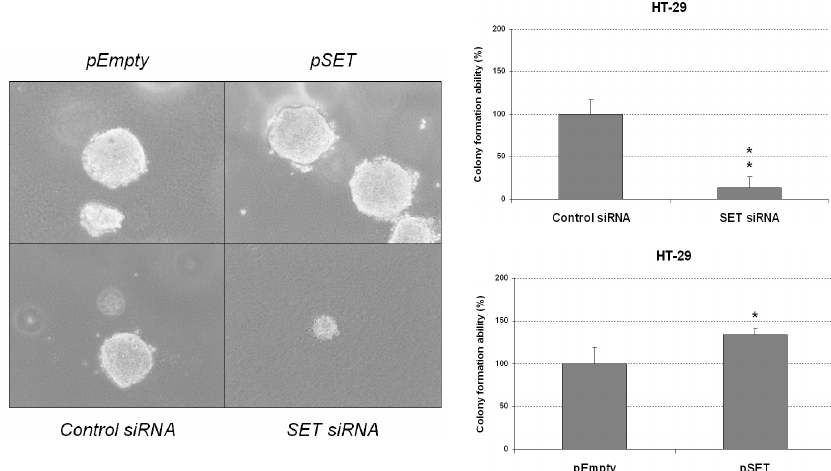
Figure 3. SET deregulation affects CRC colony-forming ability. Colony-forming assays showing the effect of SET silencing and SET overexpression on the anchorage-independent cell growth of HT-29 cells; * p < 0.05; ** p < 0.01.